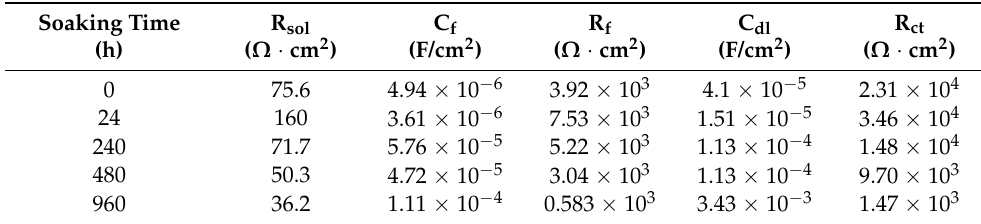
Table 2. Equivalent circuit parameters of impedance spectrum fitting of TP2 copper in formic acid solution.